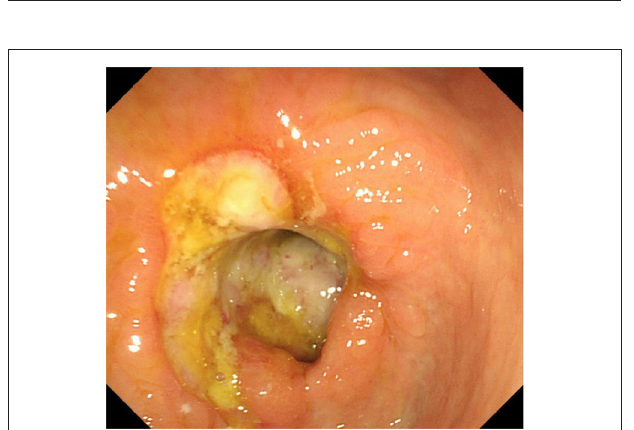
FIGURE 2 | Colonoscopy revealed a cecal enormous ulcer.